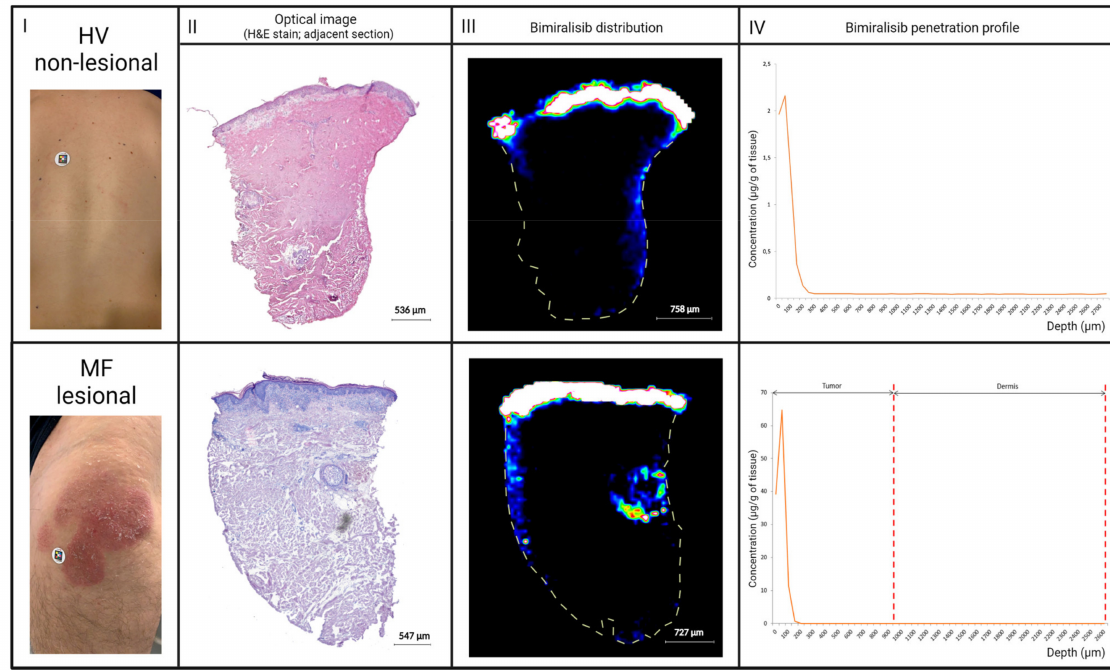
Figure 5. Individual cutaneous pharmacokinetics of a single HV compared to a single early-stage MF patient. Left to right: (I) Clinical picture by SCARLETRED imaging. (II) H&E slide visualizing epidermis and dermis. (III) Bimiralisib distribution by MALDI image. Distribution in the lateral sides of the dermis of both biopsies is considered punch contamination. (IV) Penetration profile of areas selected without